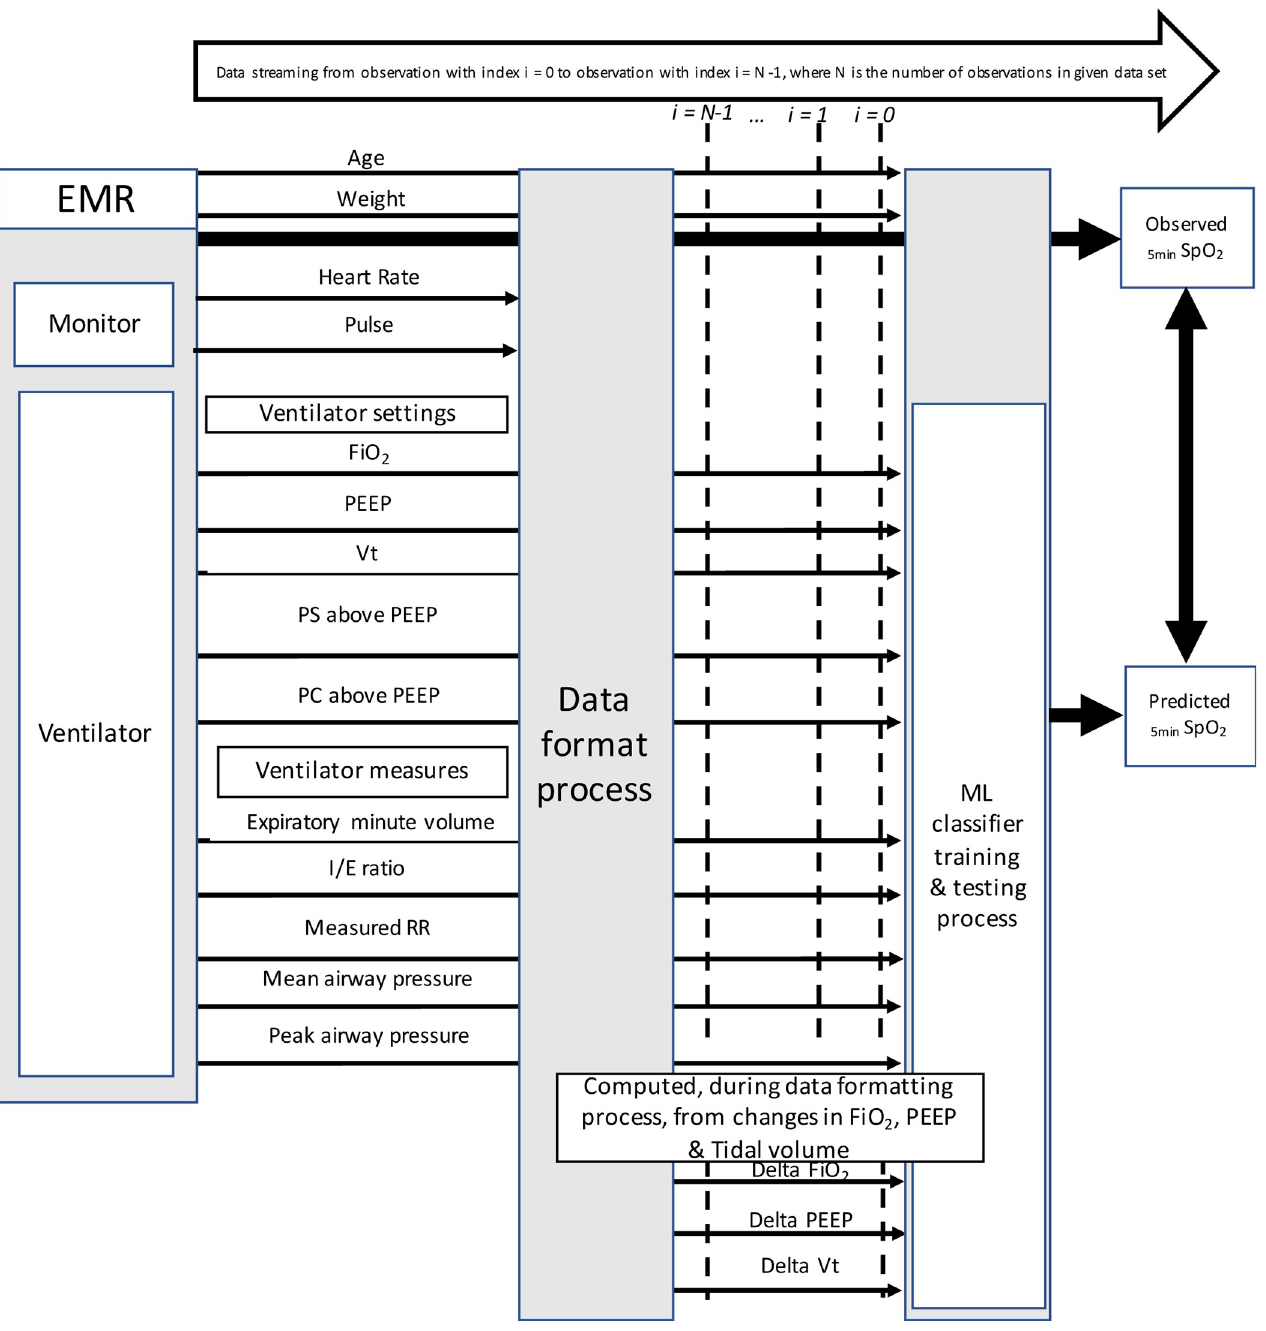
Fig 1. Schematic description of the items involved and analysis process. EMR: electronic Medical Record, FiO 2 : inspired fraction of Oxygen, Vt: tidal volume, PEEP: Positive end expiratory pressure, PS above PEEP: pressure support level Above PEEP, PC above PEEP: pressure control level above PEEP, I:E Ratio: inspiratory time over expiratory time, Measured RR: respiratory rate measured by the ventilator. 5min SpO 2 : SpO 2 observed 5 min after PEEP, FiO 2 , tidal volume, PS above PEEP, PC above PEEP change, ML: machine learning. Heart and pulse rate were only used to validate the database SpO 2 value (see below and S1